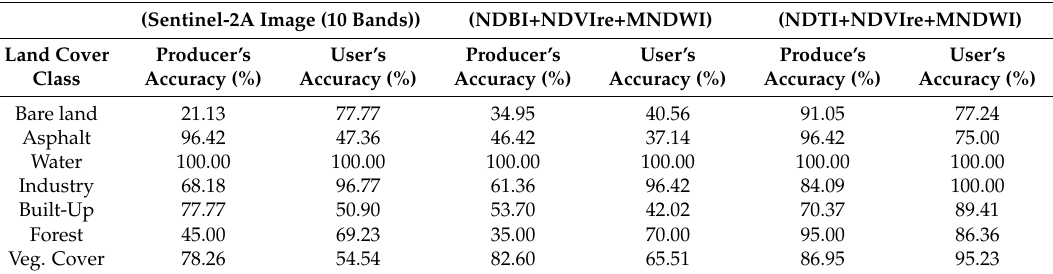
Table 8. Classification accuracies of different approaches for the Konya region.